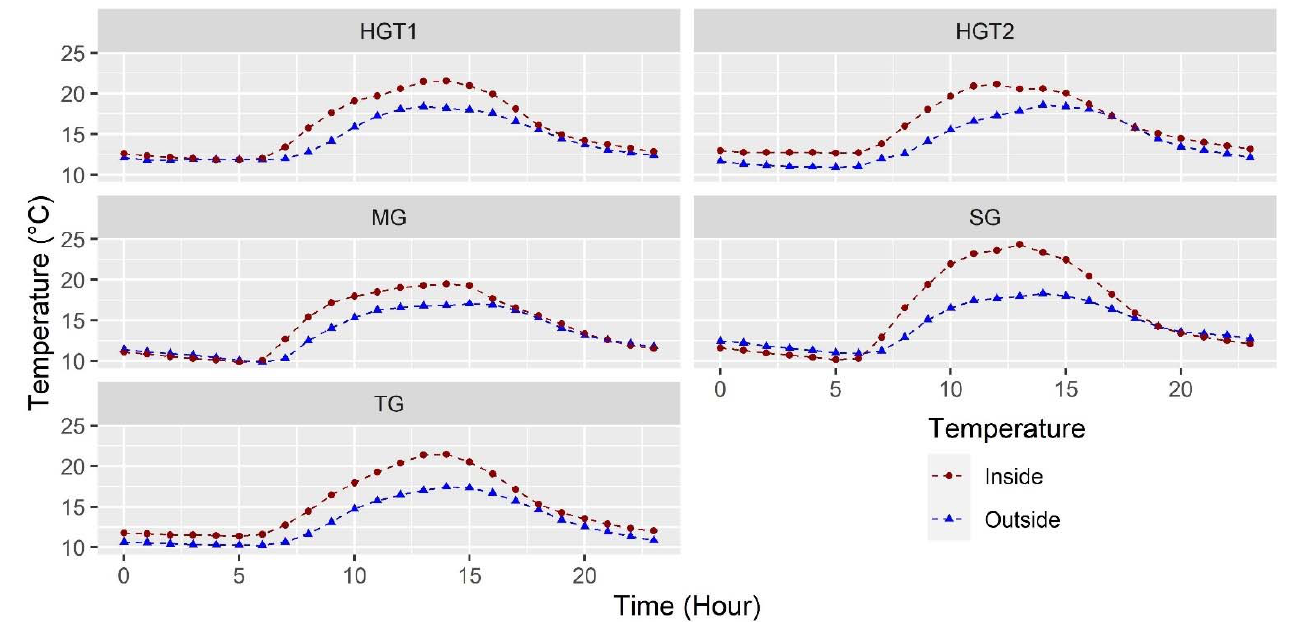
Figure 1. Mean temperature behavior for the 40 sensors in the indoor environment and mean outdoor temperature for each of the greenhouses evaluated.